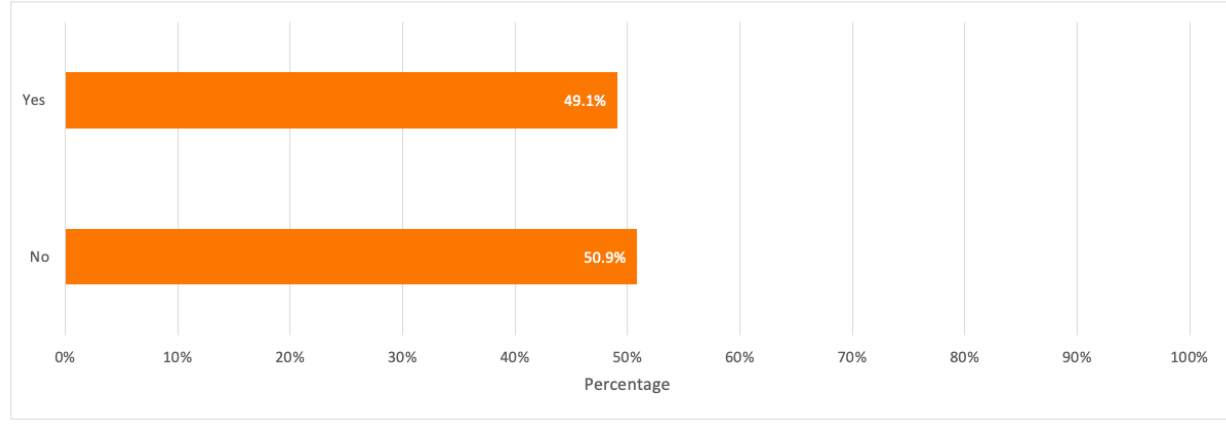
Figure 4. Respondents’ awareness of the practice of e-waste recycling.